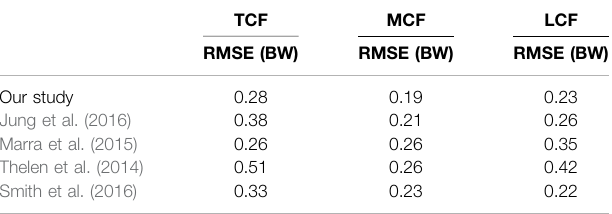
TABLE 2 | Model accuracy of this study compared to previous